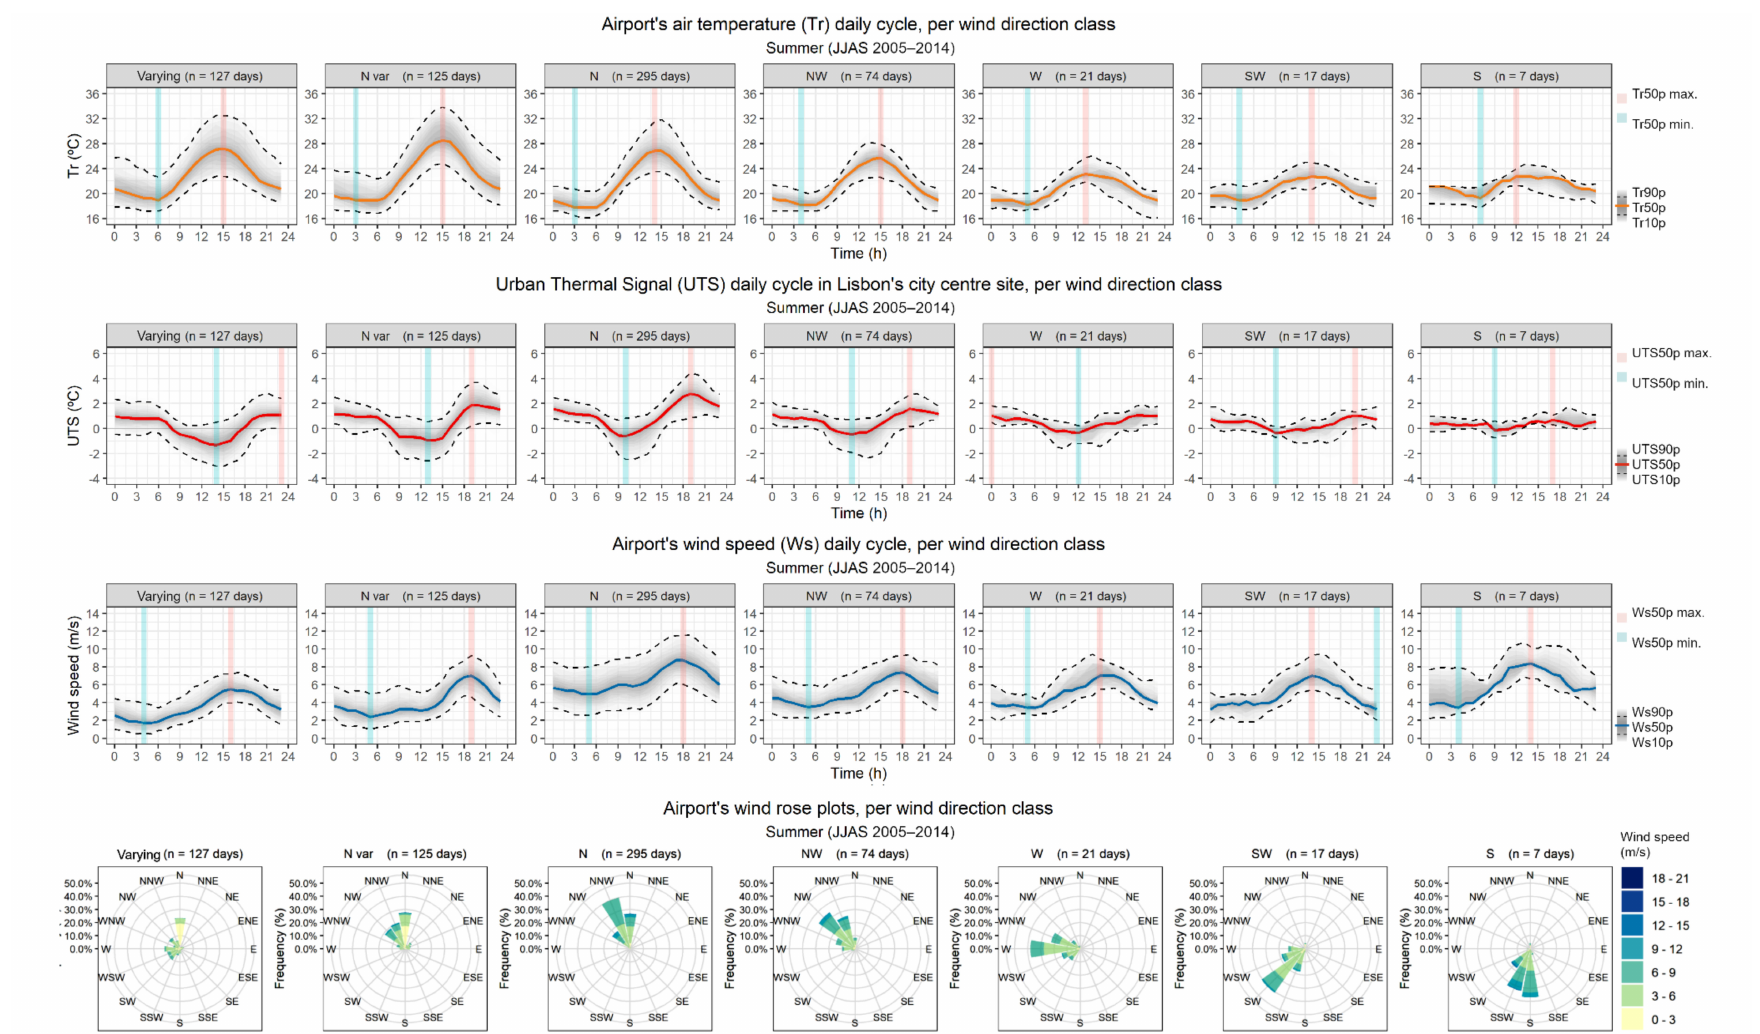
Figure 3. Daily cycles of the airport’s air temperature (Tr), city center urban thermal signal (UTS) (at the RES site), airport’s wind speed (Ws) and corresponding wind roses. The hourly statistical distribution curves represent the 10th, 50th and 90th percentiles (10p, 50p and 90p, respectively), per wind direction-based